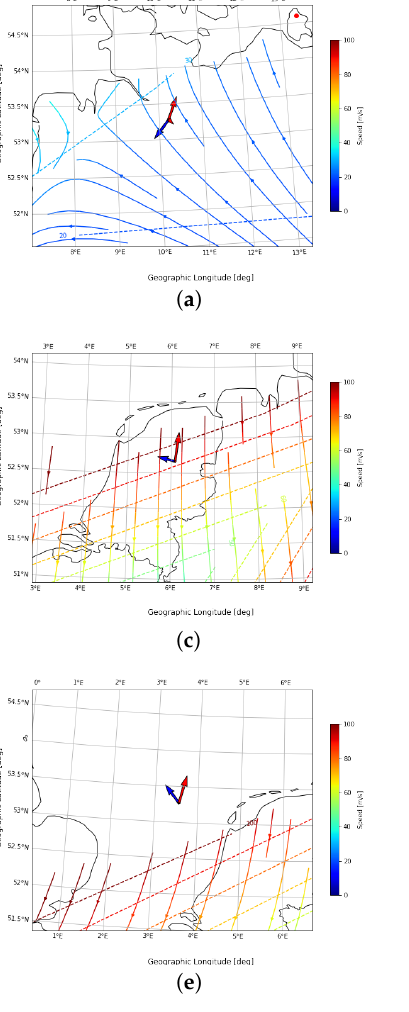
Figure 20. Spatial distribution of plasma drift velocity for the peaks 1-5 (panels ( a – e ), respectively) of L79324. Streamlines show plasma velocity vectors based on four digisondes (outside the map’s scope), blue lines: isolines of horizontal speed. Blue arrow: LOS propagation direction, red arrows: fitted directions of the disturbances based on 4 minutes central period wavelet coefficients, scaled by the percentage of explained